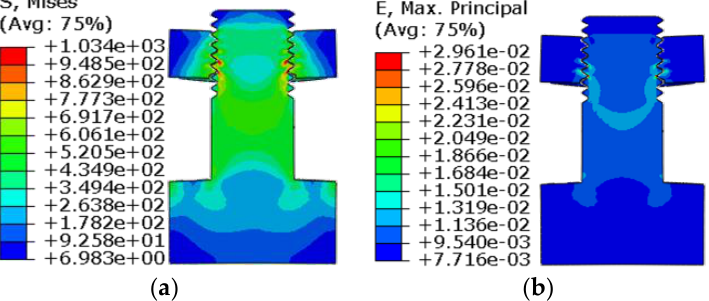
Figure 11. Von Mises equivalent stress and maximum principal strain contours of the bolt and nut at 550 ° C: ( a ) Von Mises equivalent stress; ( b ) maximum principal strain.